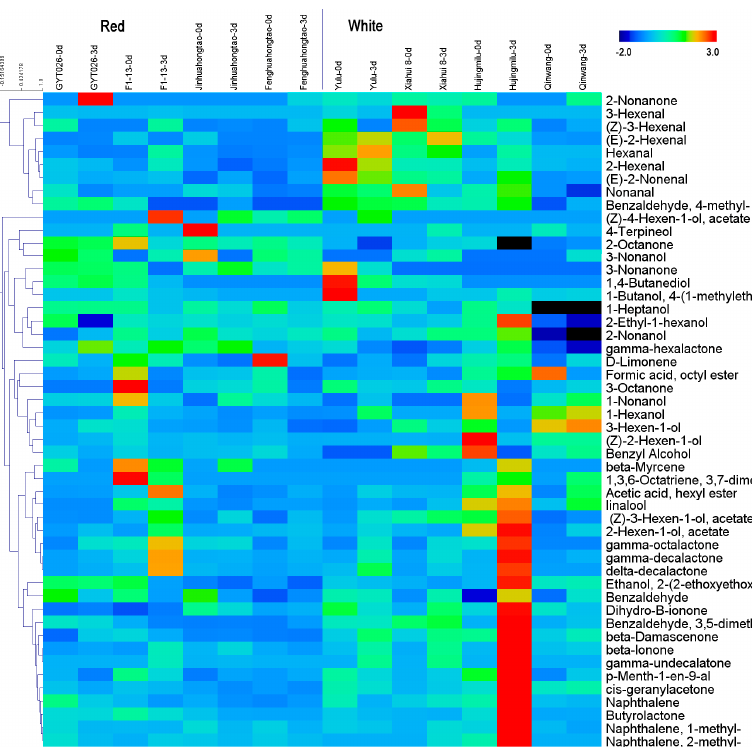
Figure 3. Heatmap display of peach fruit volatiles measured by GC-MS.